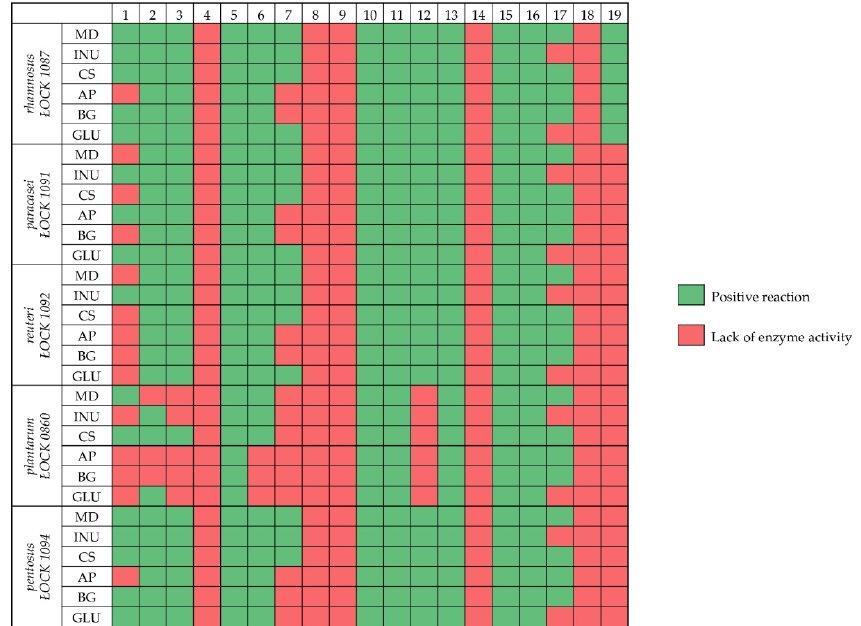
Figure 2. Heatmap presenting the Lactobacillus spp. strains enzymatic profile in relation to Figure2. Heatmappresentingthe Lactobacillus spp. strainsenzymaticprofileinrelationtocarbohydrates